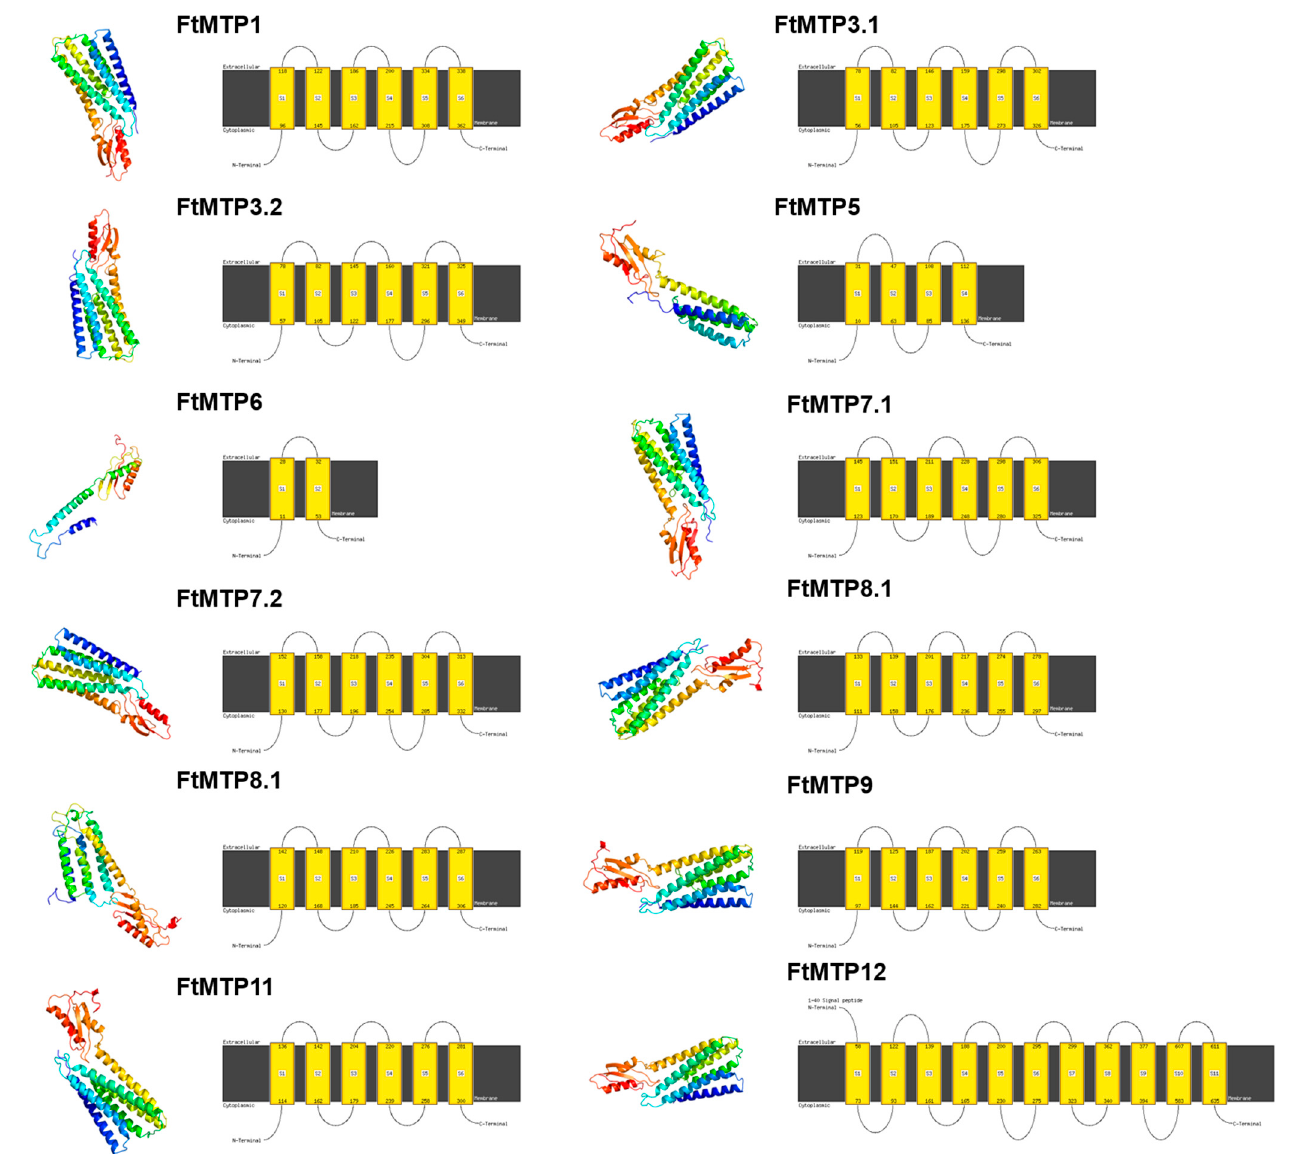
Figure 3. Structure prediction analyses of FtMTP proteins. Models had been generated by using Phyre 2 server in normal mode and were visualized by rainbow color from N to C terminus and organized in FtMTP1, and FtMTP3.1 to FtMTP12. For the left pictures, the coils and the smooths represented alpha-helices and beta-sheets, respectively; For the right pictures, the black line represented protein sequences, and the yellow boxes represented transmembrane helices.